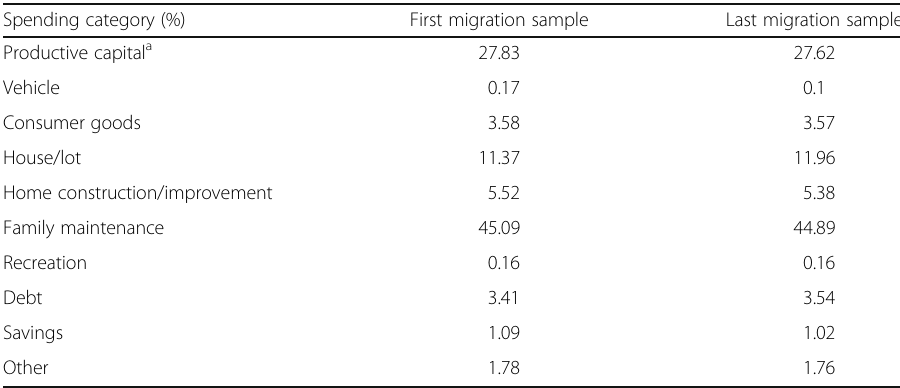
Table 4 Use of remittance